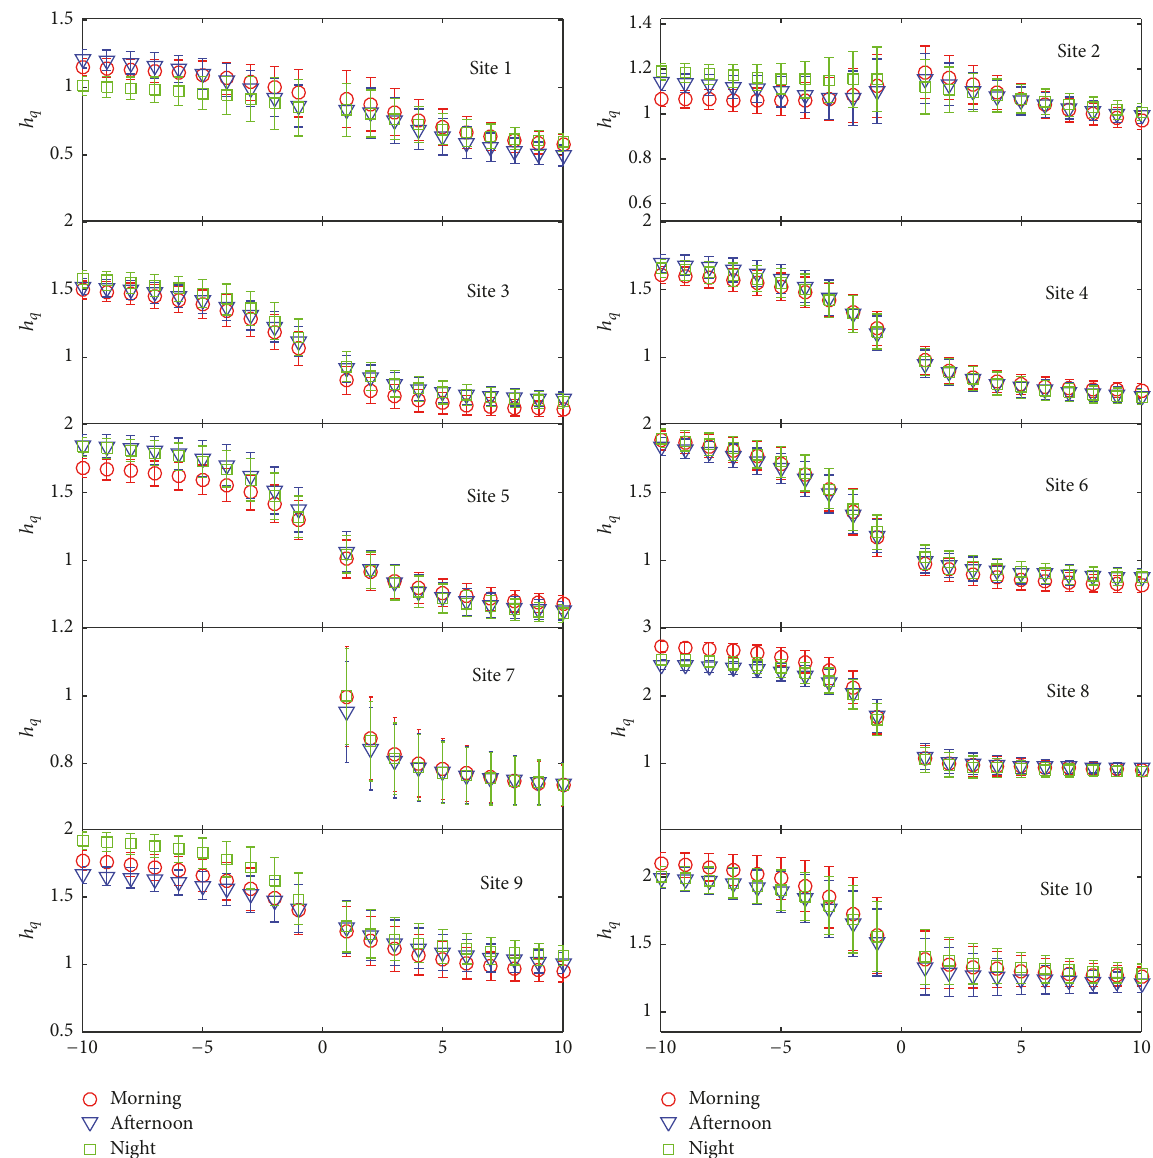
Figure 9: The generalized Hurst exponents ℎ(𝑞) for ten representative daily water level records at different times of a day. The errors bars are based on the linear least square fit which is used to estimate ℎ(𝑞) and reveal 95% confidence